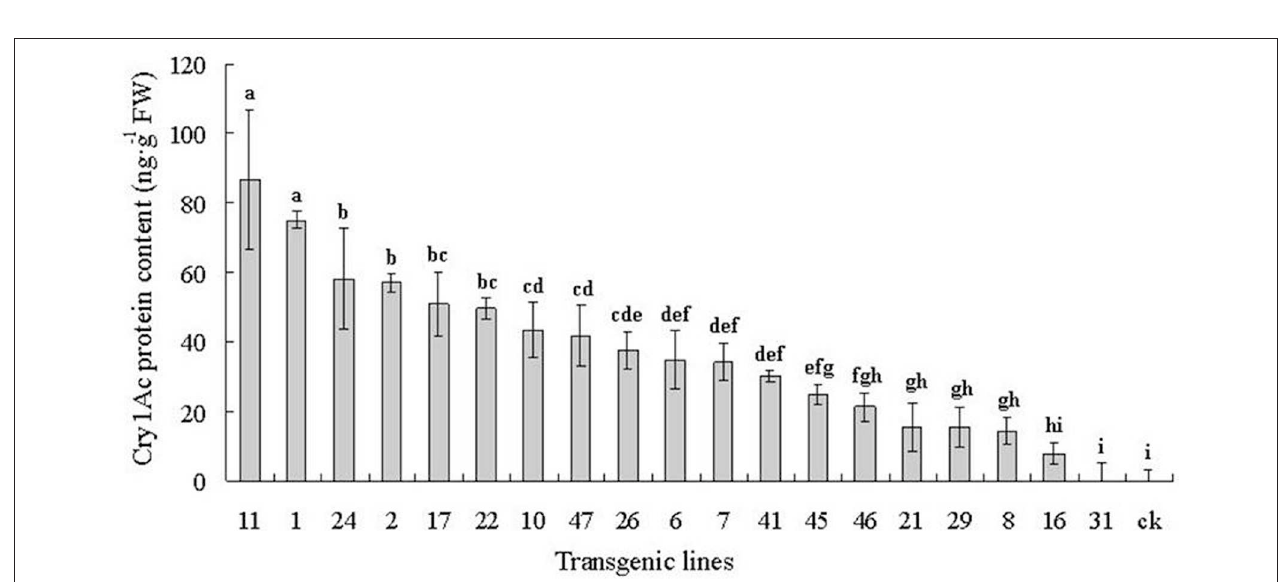
FIGURE 4 | Cry1Ac protein content of 19 6-year-old transgenic lines detected using ELISA. Cry1Ac protein content are listed from highest to lowest. The toxic protein content varied greatly among the 19 6-year-old transgenic lines from 0.00 to 86.62 ng g − 1 FW. Data are means ± SD of three replicates. Error bars represent the standard deviation of the mean. Different letters above the bars indicate a statistically significant difference between the transgenic lines at the P < 0.05 level according to Duncan’s multiple range test.